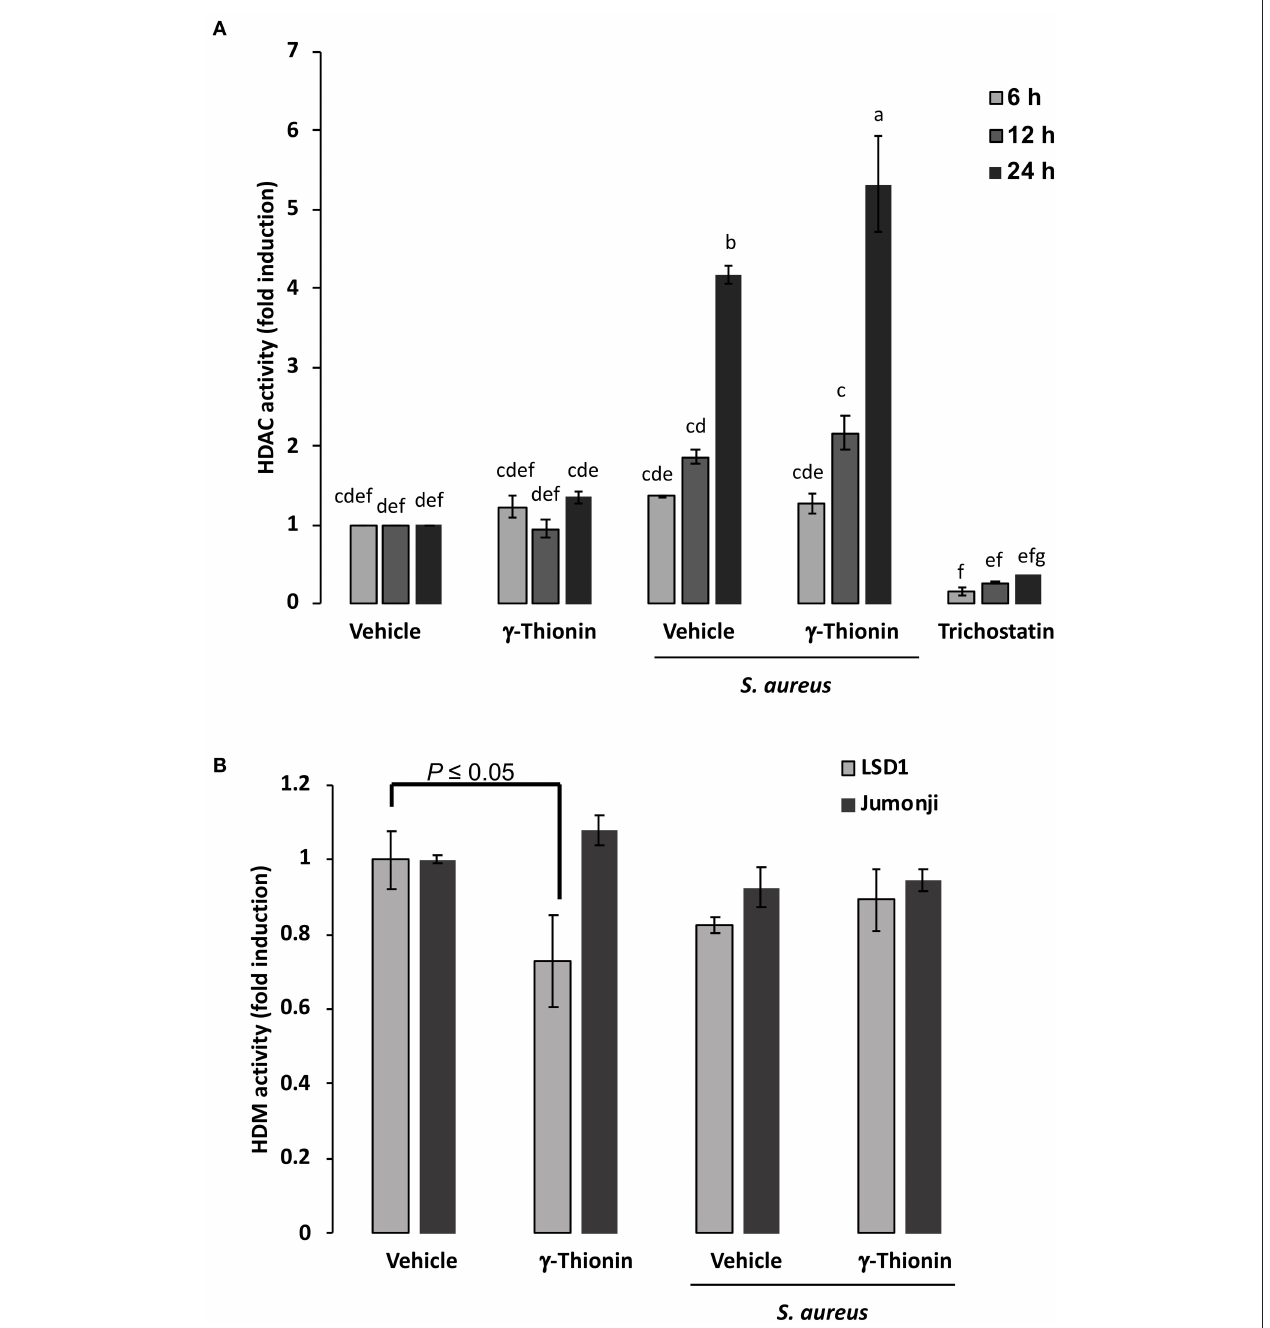
FIGURE 4 | HDAC and HDM activation in bMECs treated with γ -thionin and infected with S. aureus . bMEC lysates were obtained at 6, 12, or 24h of treatment with γ -thionin (100ng/ml) with or without 2h of S. aureus infection and were incubated with (A) the substrate for Class I and II HDACs accordingly to manufacturer’s instructions. Total HDAC enzyme activity was determined by using the HDAC fluorometric cellular activity assay Fluor de Lys ® . Each bar shows the mean of HDAC activity of cells from two different experiments ± SD, which were run in duplicate ( n = 4), considering the expression of control cells (vehicle, DMSO 0.02%) as 1 (data normalized). Different letters indicate significant differences between each condition (one-way ANOVA, post-hoc Tukey test P ≤ 0.05); Trichostatin (1 µ M) was used as an inhibitor of HDCAs. In (B) , bMEC lysates were obtained at 24h of treatment with γ -thionin (100ng/ml) with or without 2h of S. aureus infection and were incubated with the substrates for LSD1 and Jumonji demethylases (HDMs). Each bar shows the mean of HDM activity of cell lysates from two different experiments ± SD , which were run in duplicate ( n = 4), considering the expression of control cells (vehicle, DMSO 0.02%) as 1 (data normalized). t -test ( P ≤ 0.05) was performed between treatments for the same